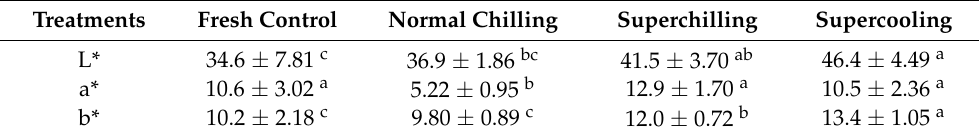
Table 1. Comparisons of CIE color parameters of beef loins after 15 days of preservation.